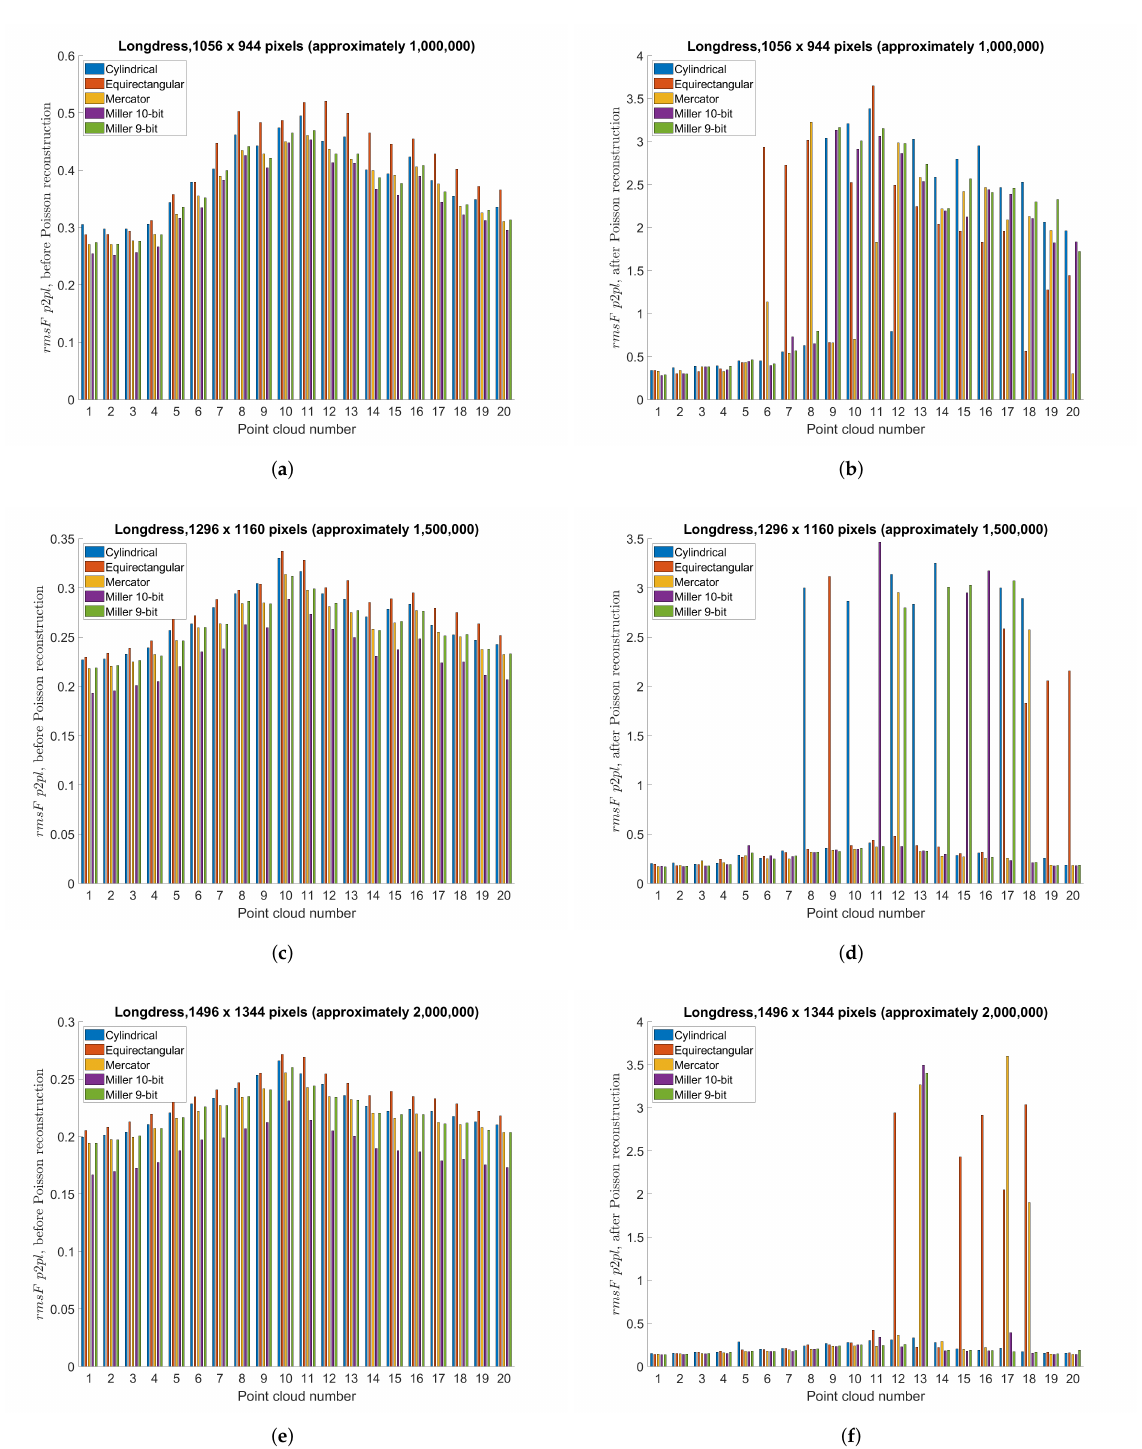
Figure 15. Point-to-plane objective measure per point cloud, using cylindrical, equirectangu- lar, Mercator, Miller 10-bit and Miller 9-bit projections: ( a ) before Poisson reconstruction, pro- jection area 1056 × 944 pixels (approximately 1,000,000); ( b ) after Poisson reconstruction, projec- tion area 1056 × 944 pixels (approximately 1,000,000); ( c ) before Poisson reconstruction, projec- tion area 1296 × 1160 pixels (approximately 1,500,000); ( d ) after Poisson reconstruction, projection area 1296 × 1160 pixels (approximately 1,500,000); ( e ) before Poisson reconstruction, projection area 1496 × 1344 pixels (approximately 2,000,000); ( f ) after Poisson reconstruction, projection area 1496 × 1344 pixels (approximately